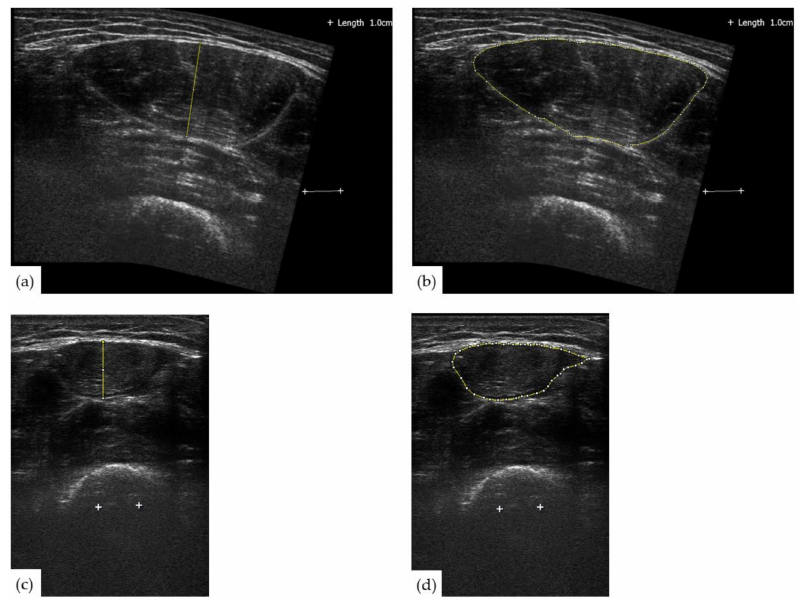
Figure 1. Examples of rectus femoris muscle thickness and CSA captured via ultrasonography for one participant. ( a ) Rectus femoris muscle thickness at 50% of leg length captured using the panoramic feature. ( b ) Same as A but showing muscle CSA. ( c ) Rectus femoris muscle thickness at 75% of leg length captured using a standardized B-mode image. ( d ) Same as C but showing muscle